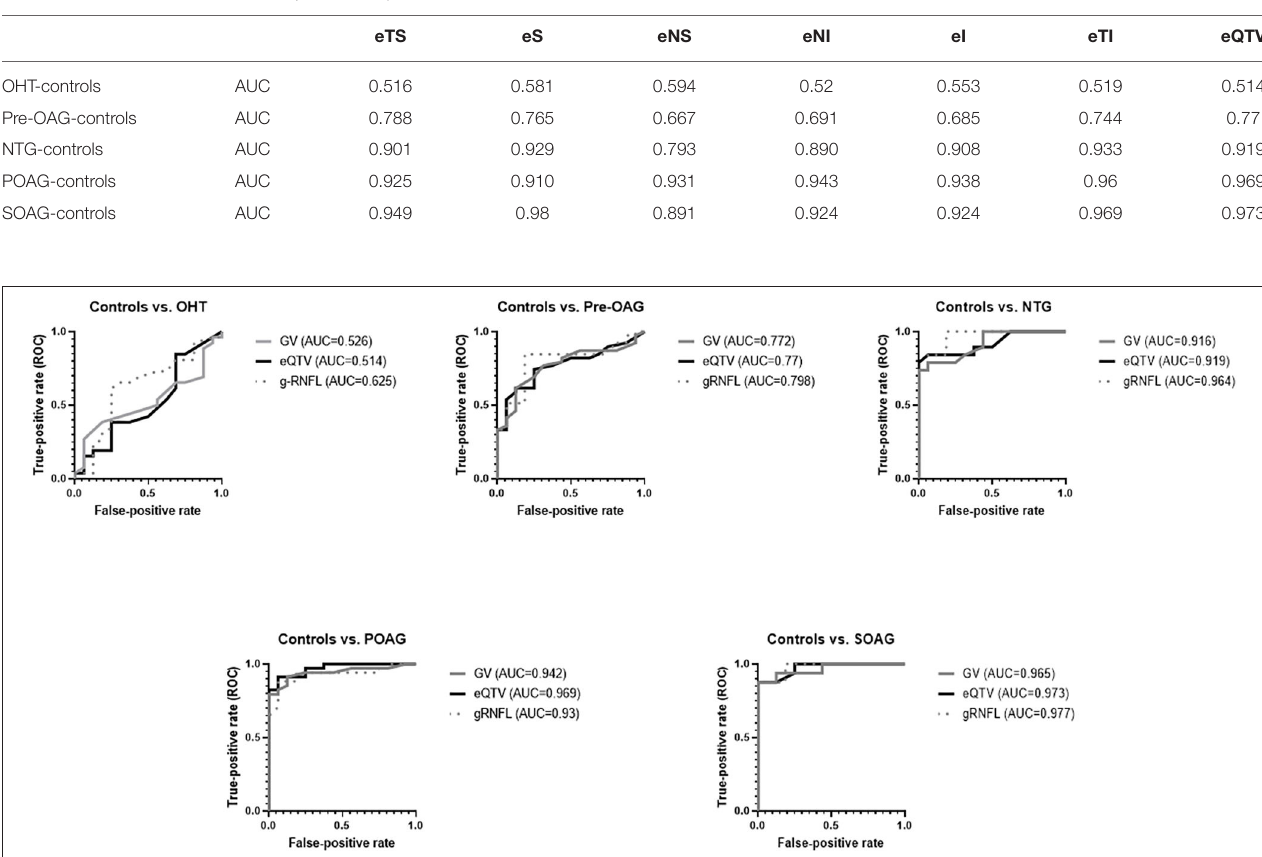
fractional deviations within the whole area of the map)